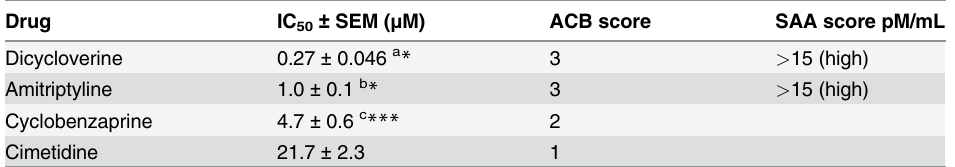
Table 2. Summary of the IC 50 ( μ M) values obtained for each antagonist drug with their respective Anticholinergic Cognitive Burden (ACB) and Serum Anticholinergic Activity (SAA) scores. Drug